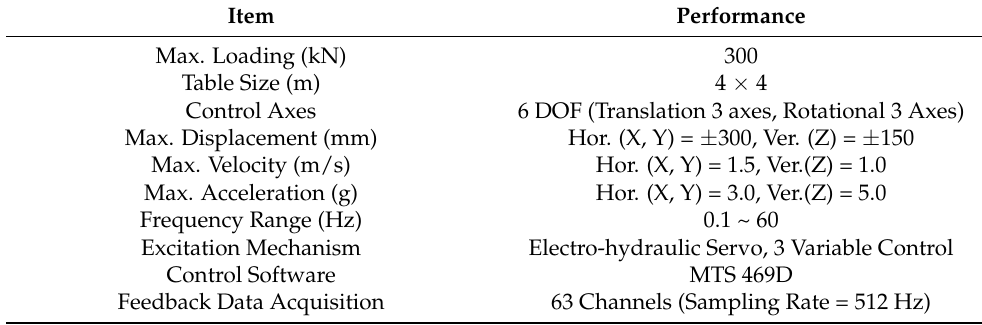
Table 3. Shaking table